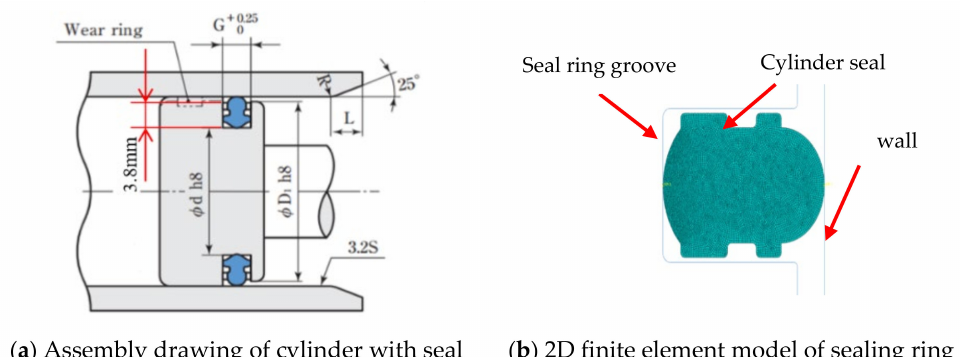
Figure 5. Finite element model of the sealing ring.